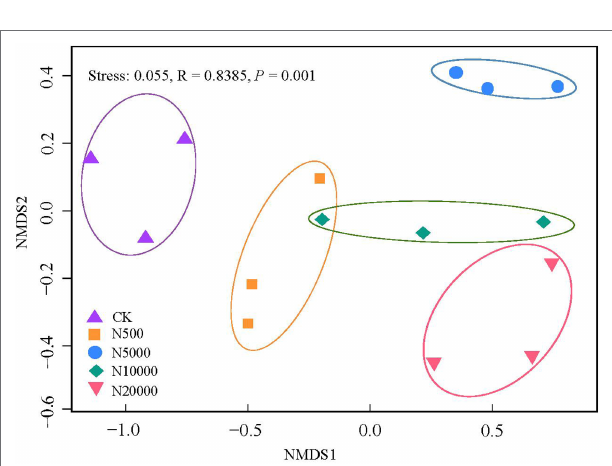
FIGURE 3 | Non-metric multidimensional scaling (NMDS) ordinations derived from the Bray–Curtis dissimilarity matrices showing the similarity of the antibiotic resistance gene profiles of the manure between the different group farms. The stress value is lower than 0.10, indicating that the data are well represented by the two-dimensional